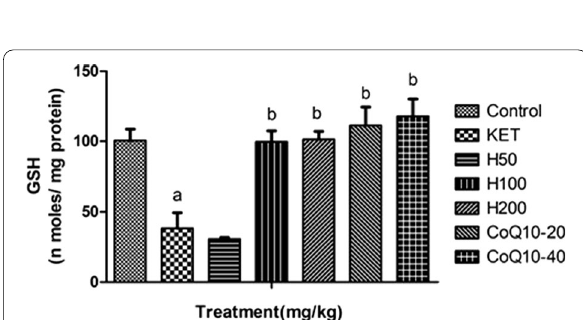
Fig. 6 Effect of Hesperidin and Coenzyme Q10 on GSH levels in the hippocampus regions of the brain. Data were analyzed by one-way ANOVA followed by Tukey’s post hoc analysis. All values were expressed as Mean SEM. a p < 0.05 as compared to naive, b p < 0.05 ± as compared to ketamine. KET, Ketamine; H, Hesperidin; SEM. ±